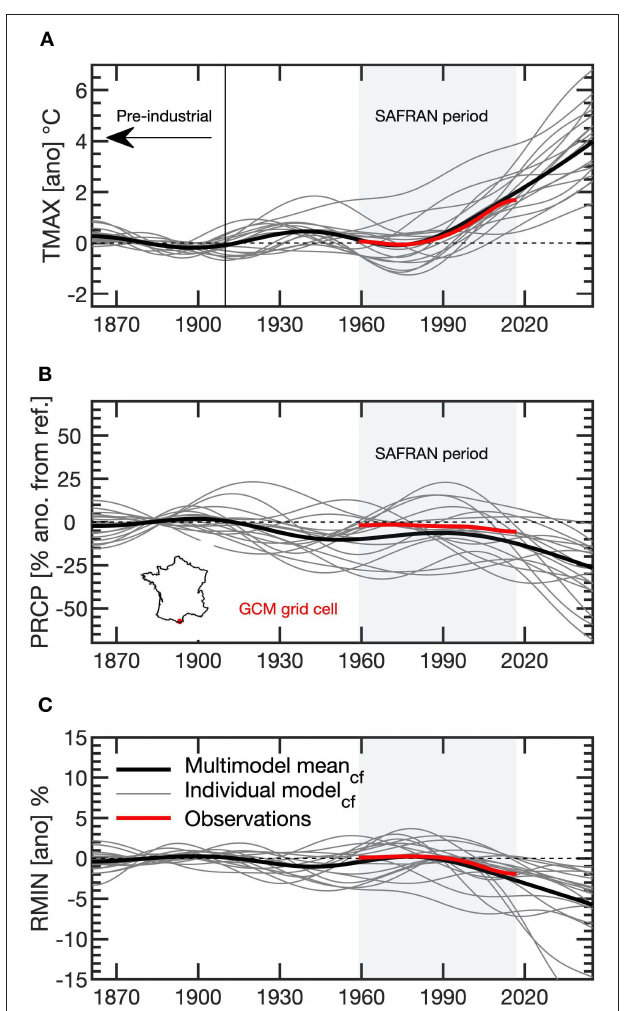
FIGURE 1 | (A) Example of the anthropogenic trend in maximum temperature (expressed as anomalies with respect to the 1861–1910 baseline) simulated by 17 GCMs (gray lines) in a given GCM grid cell at 42.5 ◦ N-2.5 ◦ E (see insert in B ) for the month of July. The anthropogenic trend is defined as the 50-year low pass filter of maximum temperature anomalies. The thick black curve shows the 50-year low pass filtered mean of the 17 GCMs. Observed anomalies in SAFRAN (1958–2017) in the corresponding grid cells are shown in red. Observed anomalies were computed with respect to counterfactual observations based on the multimodel mean (black curve). (B) Same as (A) but for precipitation (expressed as percent of anomalies with respect to the 1861–1910 baseline). (C) Same as (A) but for minimum relative